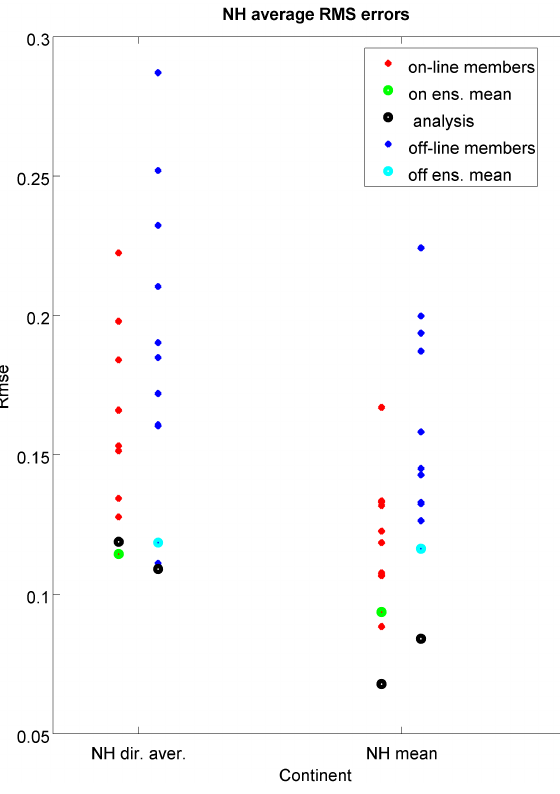
Figure 4. The rms errors for the four Northern Hemisphere con- tinents for the 17th century, for the on-line (red dots) and off-line (blue dots) ensemble members, the on-line (green dots) and off-line (cyan dots) ensemble means, and the two analyses (black dots).